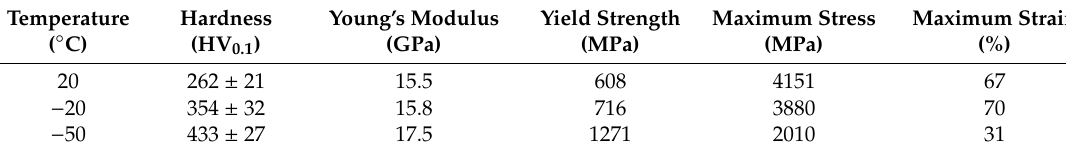
Figure 4. Compressive strain-stress curves ( a ) and strain hardening rate vs. strain curves ( b ) of Fe-Ni-P alloys before / after cryogenic treatment. Table 1. The mechanical properties data of Fe-Ni-P alloys with di ff erent treatment